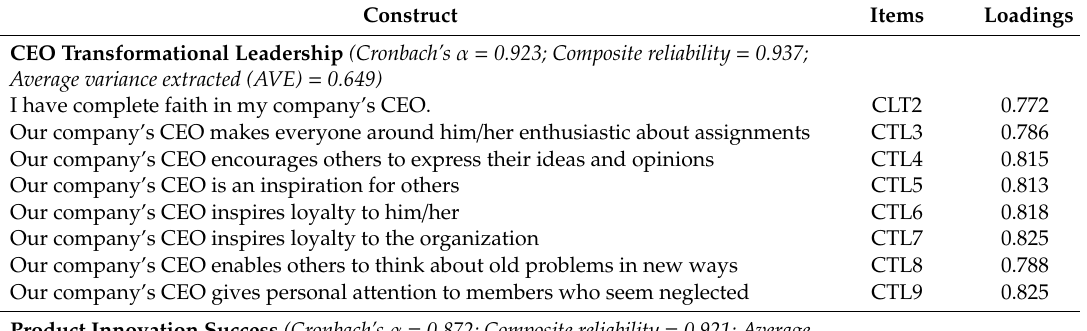
Table 3. Measurement model assessments